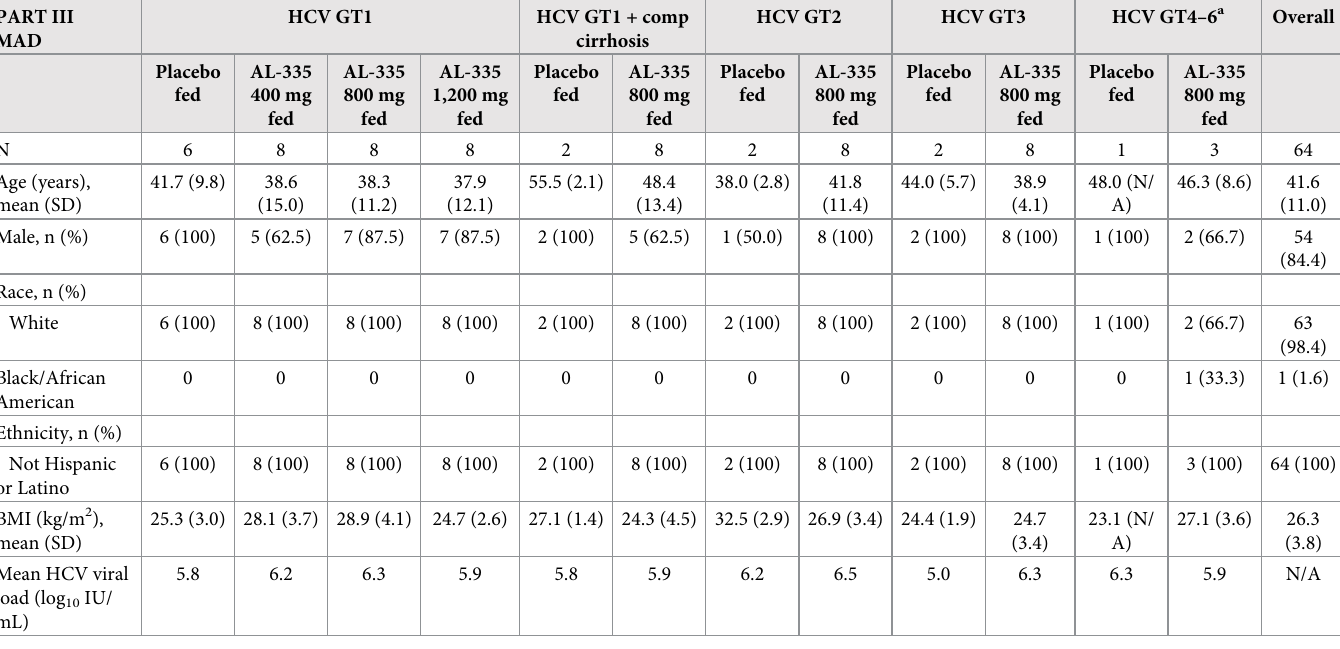
a All randomized subjects in the HCV GT4–6 cohort were infected with GT4.